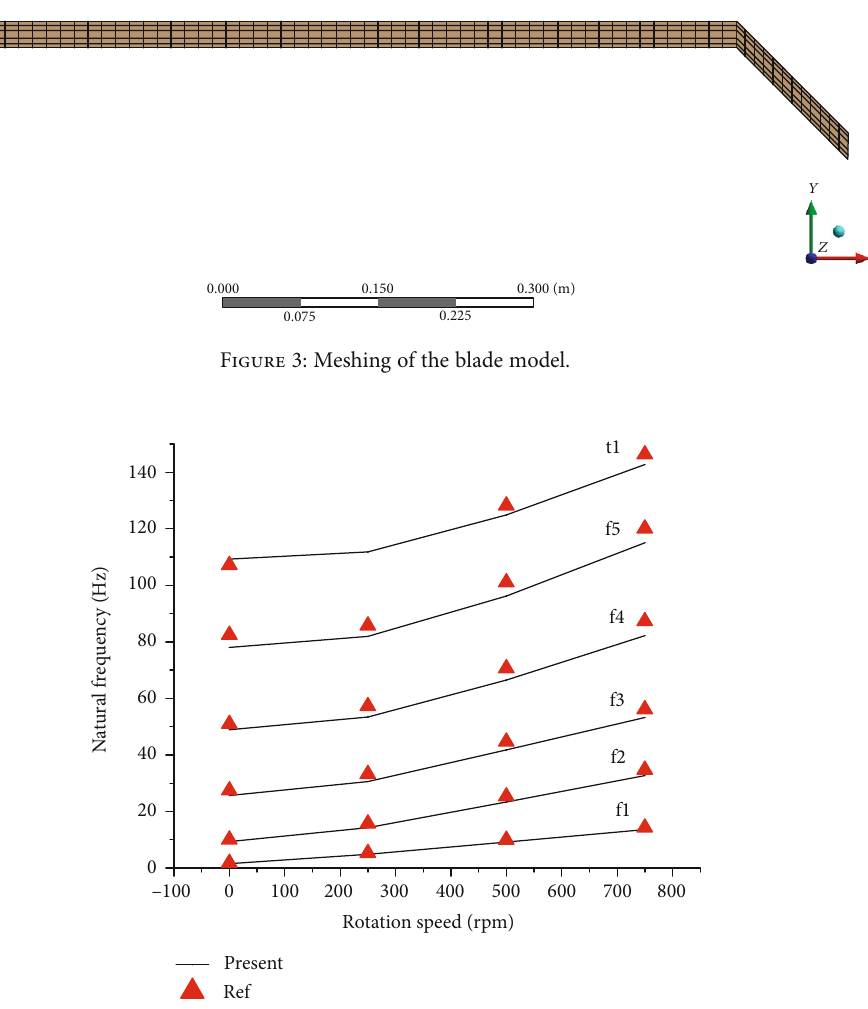
Figure 4: Natural frequencies of the blade ( Λ = 45 °